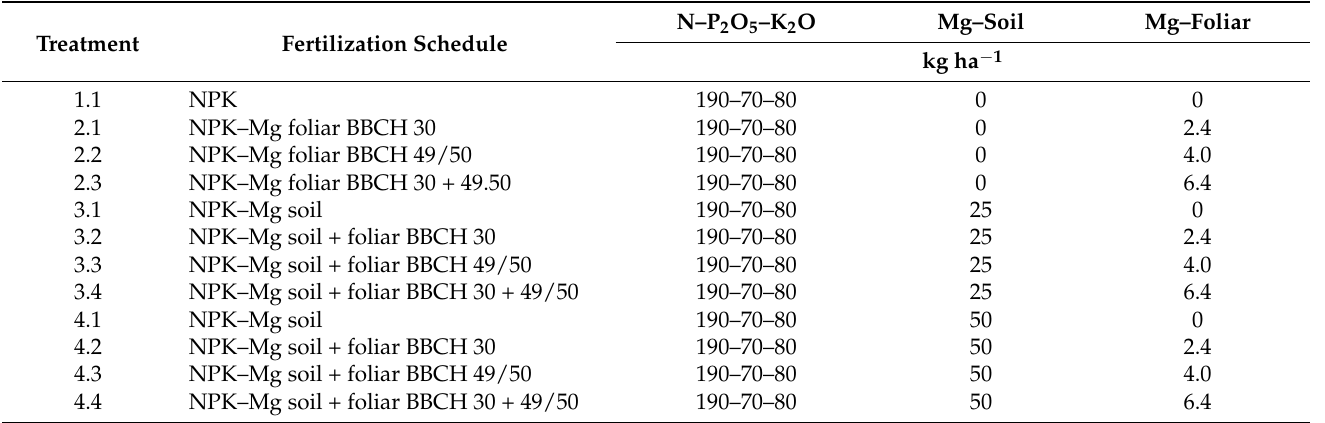
Figure 7. Weather conditions during the consecutive growing seasons. Spring barley was the fore-crop for winter wheat. The Tobak wheat variety was sown annually on 20–25 September. The soil was fertilized with Mg in the form of Kieserite (MgSO 4 · H 2 O), containing 25% MgO and 50% SO 3 . Kieserite was applied to the soil three weeks before wheat sowing. Foliar fertilization of wheat with Mg was carried out using Epsom salt (MgSO 4 · H 2 O) containing 16% MgO and 37.5% SO 3 . The amounts of the applied nutrients are shown in Table 4. Sulfur applied together with the Mg fertilizer was balanced in the first dose of N. It was used as a mixture of ammonium sulfate and ammonium saltpeter (17.5% SO 3 ). The first N dose of 80 kg ha − 1 was applied just before the beginning of the growing season in spring. The second dose of 50 kg ha − 1 was applied, and the third one of 60 kg ha − 1 at BBCH 45–47. Phosphorus at a rate of 30.1 kg P ha − 1 as triple superphosphate (46% P 2 O 5 ) and K at a rate of 66.4 kg K ha − 1 as muriate of potash (KCl) were applied together with the soil Mg. The total area of a single plot was 30 m 2 , and the harvested area was 15 m 2 . Plant protection was conducted in accordance with the codex of good practice. Table 4. Fertilization